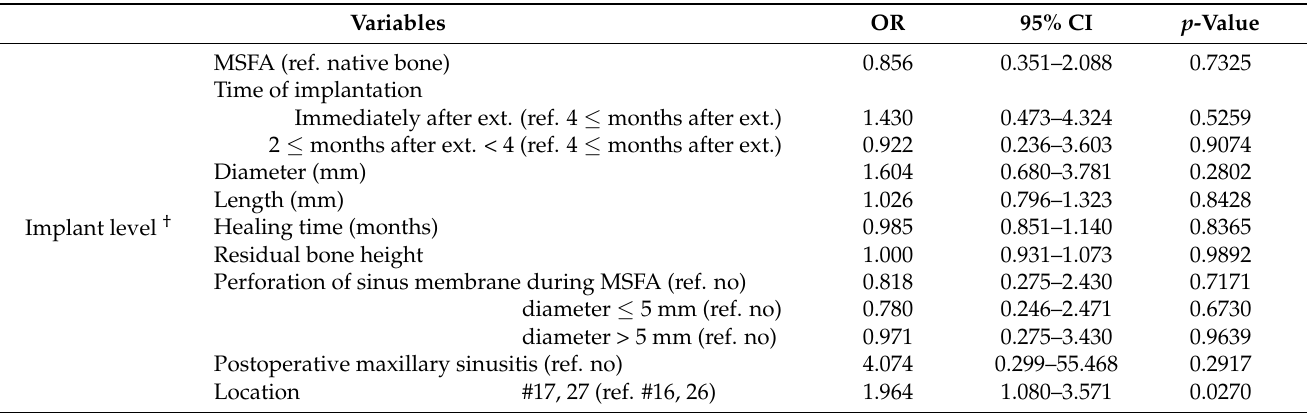
Table 5. Multivariable analysis using generalized estimation equations (GEE) for marginal bone loss.